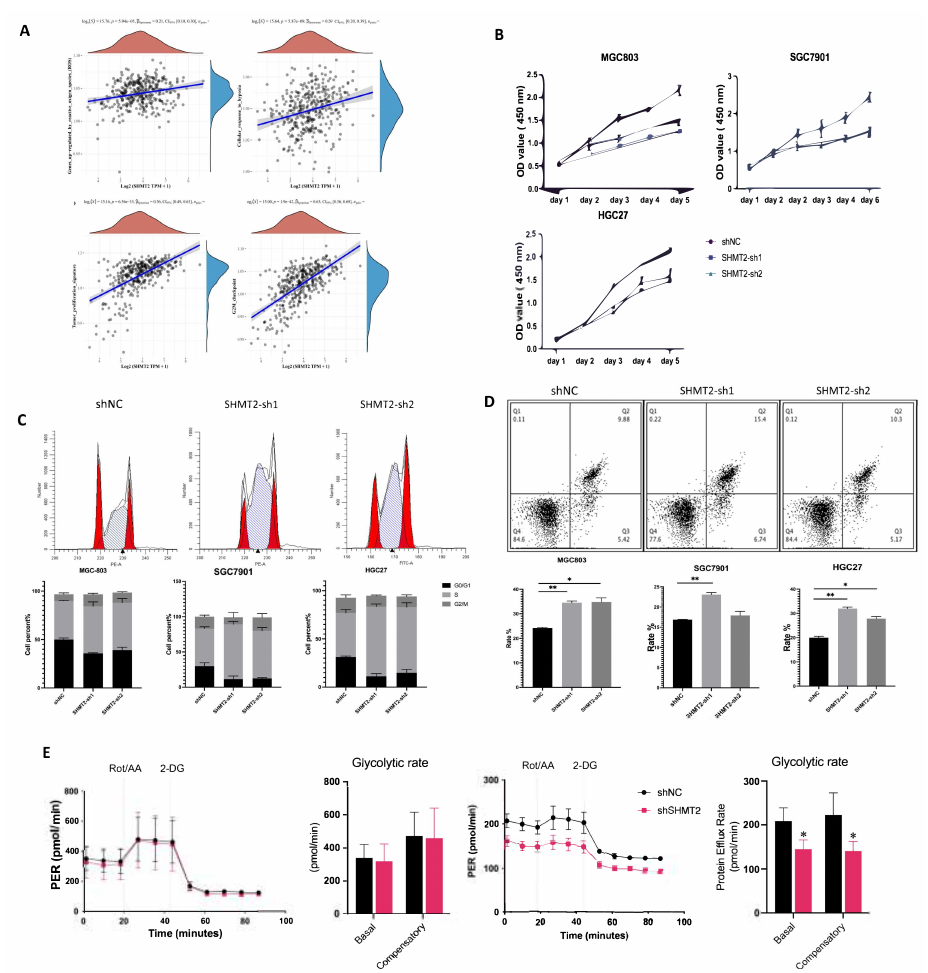
Figure 4. The deletion of SHMT2 inhibited GC cell proliferation, cell cycling, apoptosis, and invasive metastasis under hypoxia. ( A ) Spearman correlation analysis of SHMT2 with cellular response to hypoxia, gene upregulation by reactive oxygen species (ROS), tumor proliferation signature, and G2M checkpoint pathway in TCGA database. The abscissa represented the gene expression distribution, and the ordinate represented the pathway score distribution. The density curve on the right represented the trend in pathway score distribution, the upper density curve represented the trend in gene expression distribution. The value on the top represented the correlation p value, correlation coefficient, and correlation calculation method. ( B ) CCK-8 measured the proliferation of GC cells under normoxic and hypoxic conditions. ( C , D ) Effect of SHMT2 knockdown on GC cell cycle and apoptosis under hypoxic conditions. Different colors in the subfigure C indicated different groups, with black being the control group and blue being the knockdown group. ( E ) Effect of SHMT2 knockdown on the mitochondrial glycolysis rate in SGC7901 cells under normoxic and hypoxic conditions. * p < 0.05, ** p <